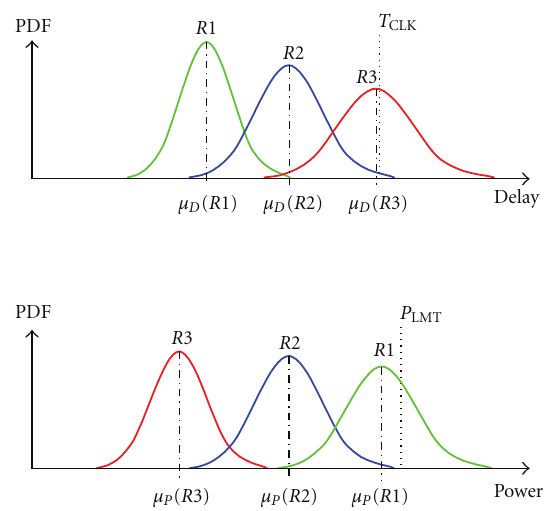
Figure 5: Motivating example of yield-driven